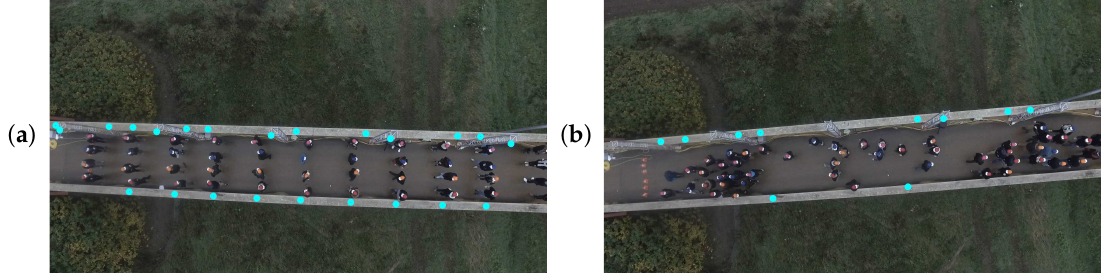
Figure 15. Example of the pose estimation algorithm using a KLT tracker: ( a ) initial frame with indication of calibration points (dots) and ( b ) 600th frame with retained calibration points using the KLT tracker.